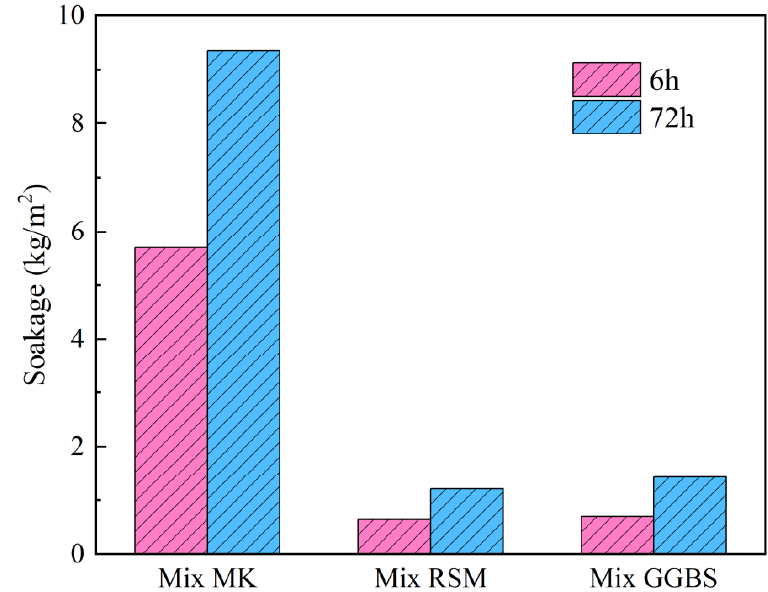
Figure 21. Soakage of geopolymer mortars.